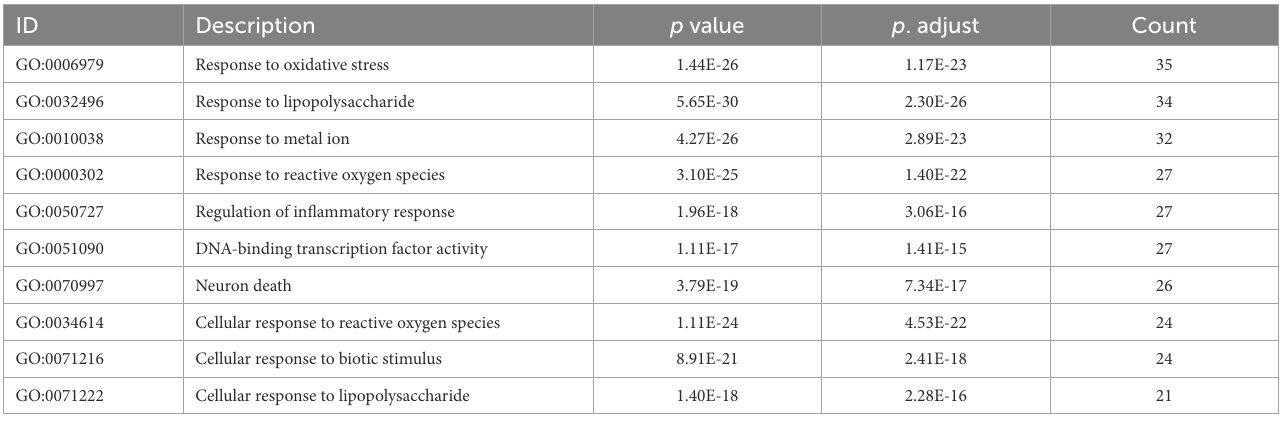
TABLE 2 Top 10 items of Gene Ontology (GO) enrichment analysis.